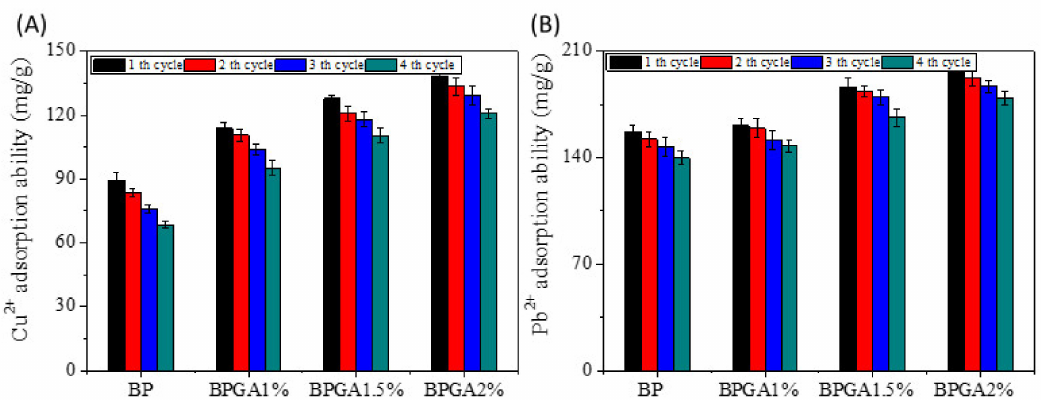
Figure 10. The reusability of the prepared adsorption material for Cu 2 + and Pb 2 + ions adsorption. ( A ) Cu 2 + , ( B ) Pb 2 +